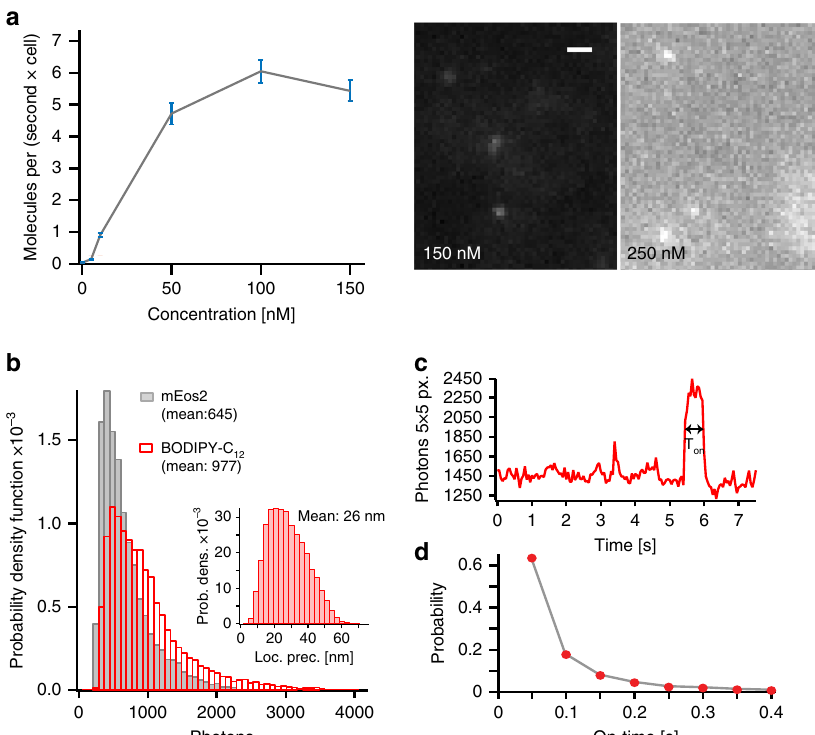
Fig. 2 Photophysical characterization and optimization D II -BODIPY-C 12 for SMLM. a The rate of single-molecule detections is dependent on the added concentration of BODIPY-C 12 (left) (number of cells>10, frames>3500 for each concentration, error: standard deviation from 5 substacks). At concentrations above 150nM the background fl uorescence prevents single-molecule detection (right). b The photon counts detected from single red-shifted D II -BODIPY states per frame is superior to mEos2, a commonly used photo-switchable fl uorescent protein (number of data points: mEos2 = 11,569, BODIPY-C 12 = 25,673). b (inset) The theoretical localization precision calculated from the photon counts has a mean of 26nm ( n = 3754 points). c The single-molecule fl uorescence intensity vs. time trace shows prolonged on-times, allowing for single-molecule tracking over several frames. d The on-time distribution follows an exponential decay with ~40% of molecules appearing in two or more frames for single-molecule tracking (right) ( n = 6569 data points, 5 cells). Scale bar: 1 µ